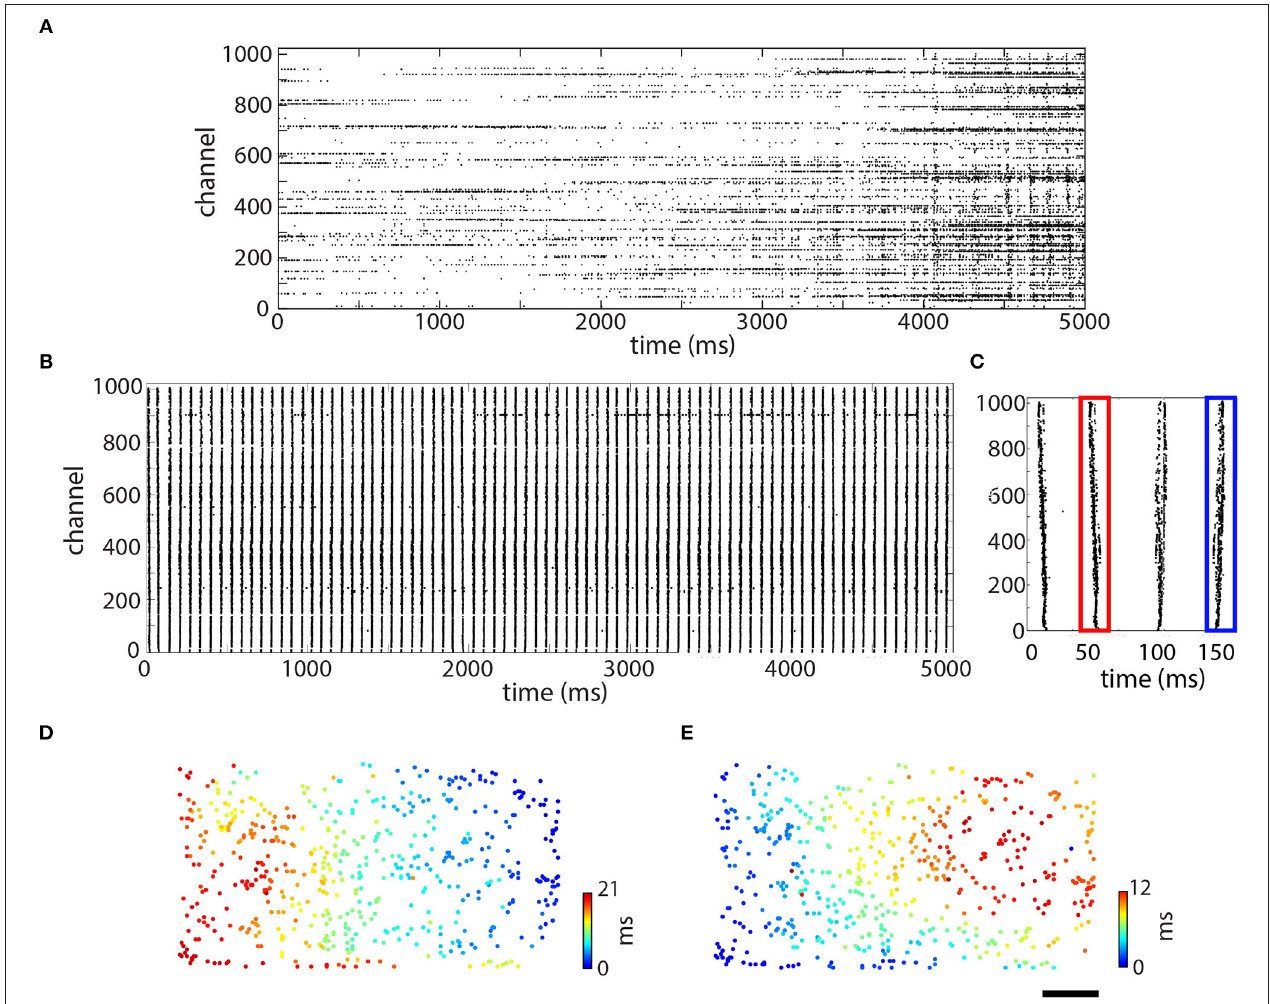
FIGURE 3 | Time and space-resolved information about spiking over the culture. Raster plots showing data taken at 19 days in vitro (DIV) (A) and 31 DIV (B) . Each of these raster plots shows 5s of data. (C) Zoom-in on first four spikes shown in (B) . (D,E) Space resolved timing information for the spikes shown in (C) . (D) Second spike, outlined in red. (E) Fourth spike, outlined in blue. Scale bar in (E) is 0.5mm and applies to (D,E)